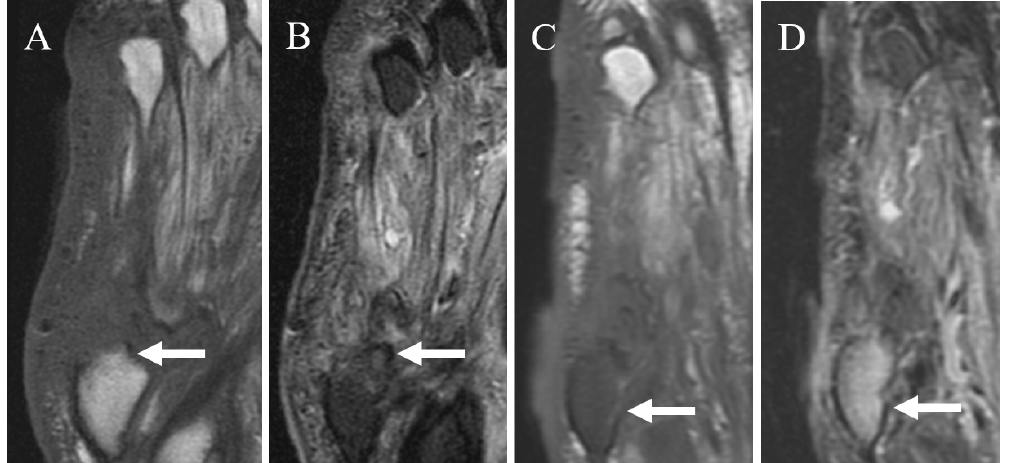
Figure 5. Coronal T1 (a) and STIR (b) images in a 62-year-old male patient with prior fifth ray amputation and a recurrent ulcer demon- strate a small amount of reticulated T1 hypointense and T2 hyperintense signal near the amputation margin of the fifth metatarsal base (arrows). Follow-up coronal T1 (c) and T2 fat-saturated images (d) obtained approximately 6 months later demonstrate marked confluent T1 hypointense and T2 hyperintense signal in the residual fifth metatarsal base (arrows) consistent with osteomyelitis.